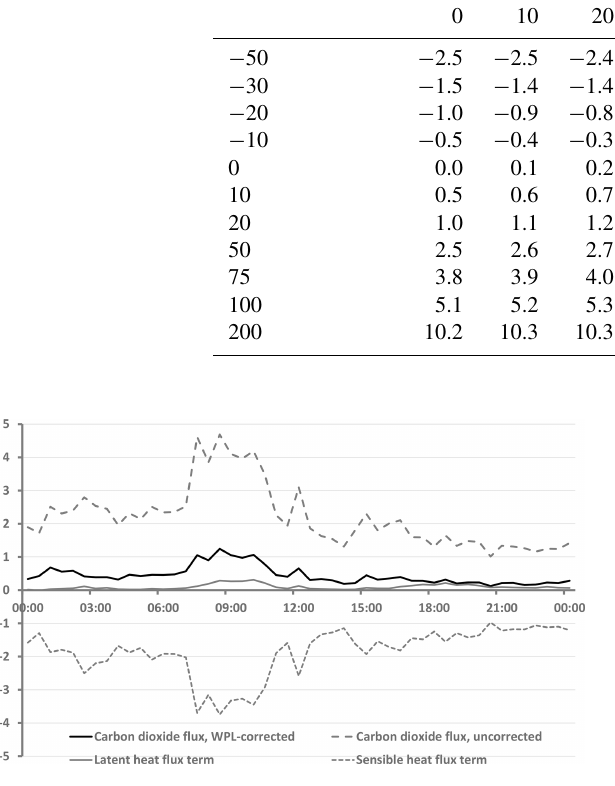
Figure 2. Comparison of WPL-corrected and uncorrected CO 2 flux together with the size of humidity fluctuation term (second term on the right-hand side of Eq. (1) and temperature fluctuation term (third term) for the data set shown in Fig.